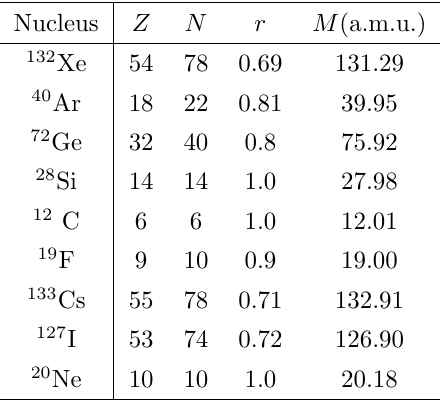
Table 2 . Main properties of the nuclei for the di(cid:11)erent target nuclei considered in this work. The di(cid:11)erent columns indicate the isotope considered, together with the number of protons and neutrons, the ratio between them r , and the value of the nuclear mass in atomic mass units (a.m.u.). For the detectors using CsI and C 3 F 8 we take the weighted average between the two elements in the